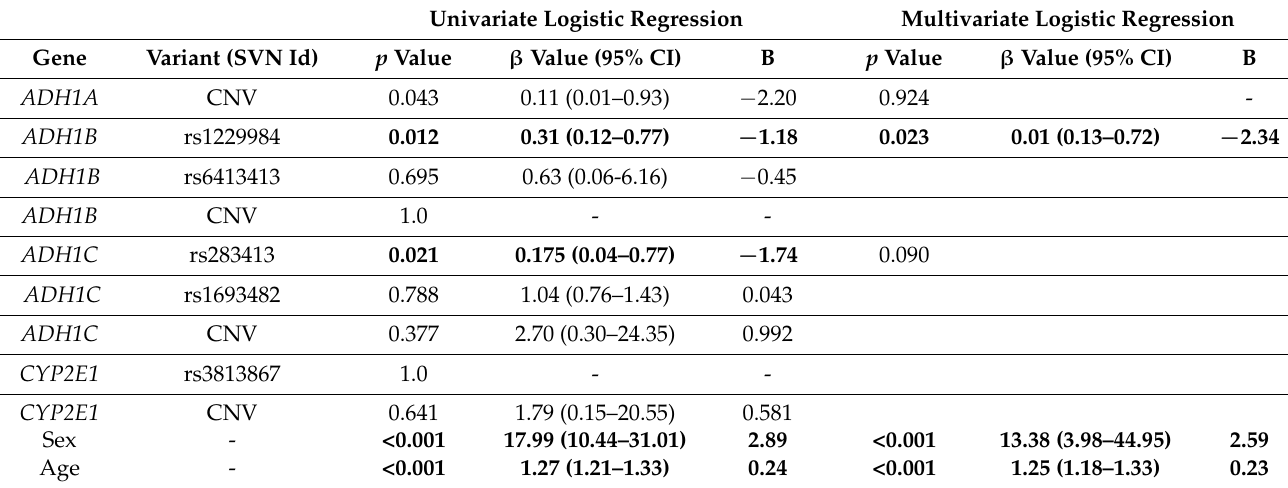
Table 4. After multivariate logistic analysis, the SNVs ADH1B rs1229984 ( p value = 0.023, β = 0.01) remained associated with the risk of developing alcohol-related liver cirrhosis. Table 4. Univariate and multivariate logistic regression